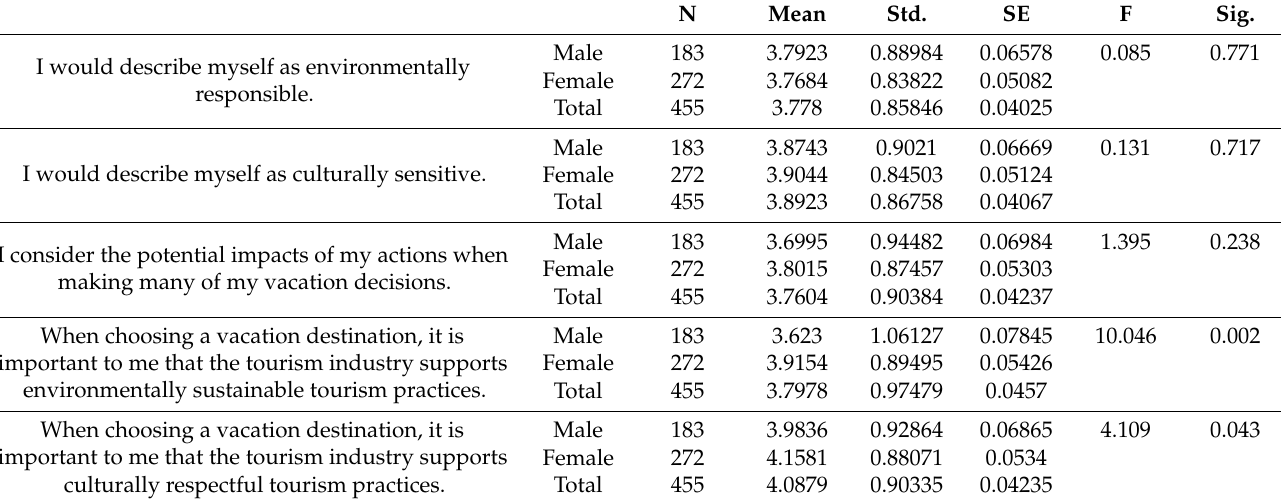
Table 7. Participants’ view of their responsibilities as leisure travelers, by gender.